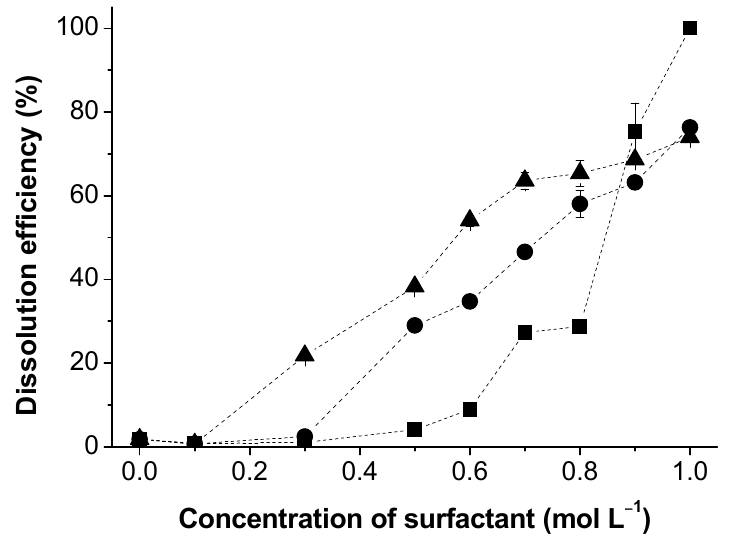
Figure 3. Dissolution efficiency of kraft lignin in water as a function of cationic surfactants: octyltrimethylammonium bromide (OTAB) (squares), decyltrimethylammonium bromide (DeTAB) (circles), and tetradecyltrimethylammonium bromide (TTAB) (triangles).